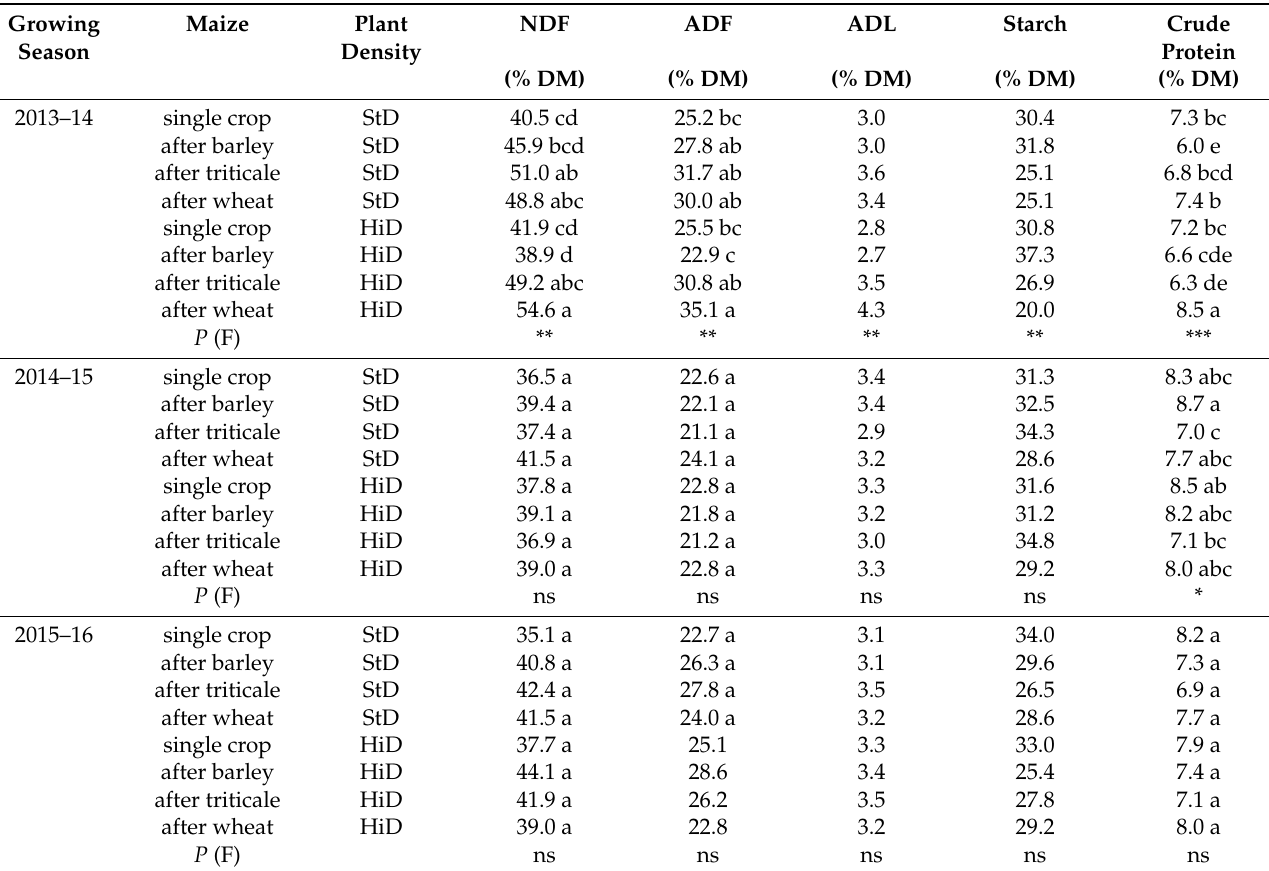
Table 7. Biomass composition of the maize crop with different sowing times 1 and plant densities 2